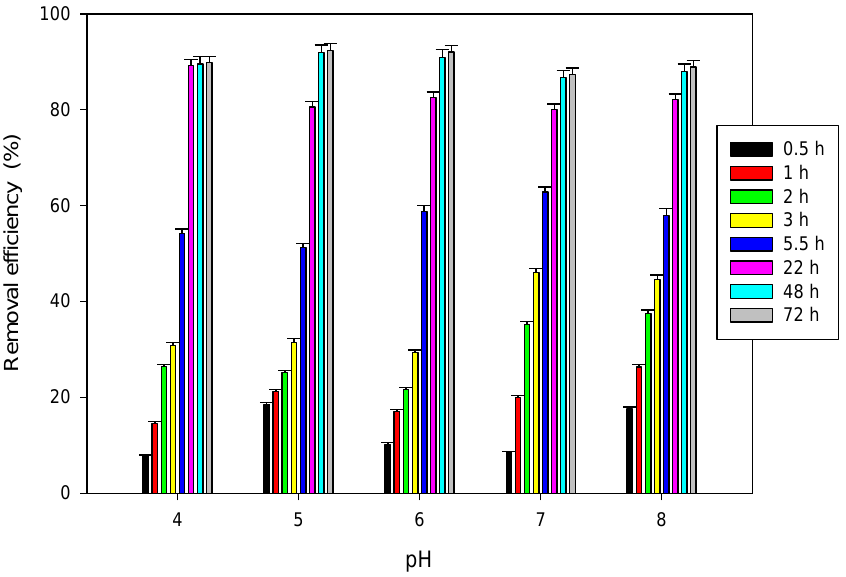
Figure 2. BPA removal efficiency of activated carbon AC-40 depending on pH at different contact times.